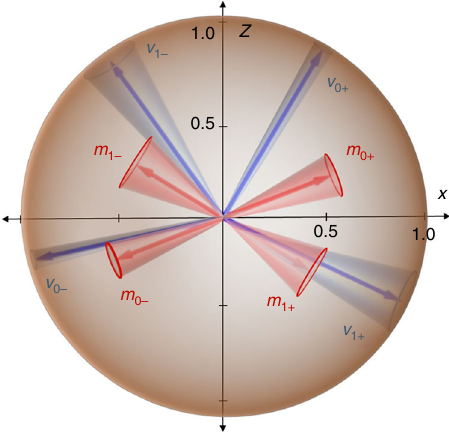
Fig. 4 Experimental results. Least uncertain states v (red) and states m that Alice is able to steer (blue). Cones show experimental errors originating from statistics (Poissonian) and systematic due to limited precision of the settings and non-ideal components. The experimental results illustrate that steering to the maximally certain state is not possible, as cones associated to v 0 + and m 0 + do not